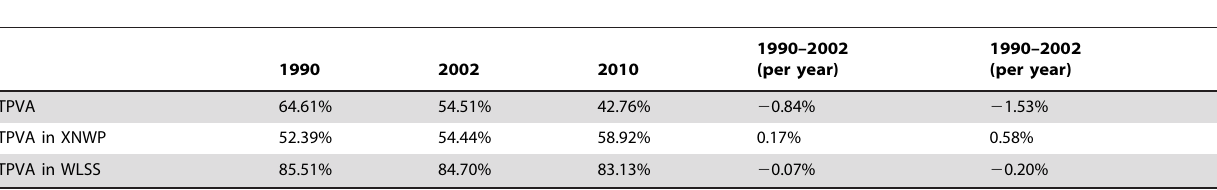
Table 2. Total percent vegetated area and changes from 1990 to 2010 for the study area and the two scenic